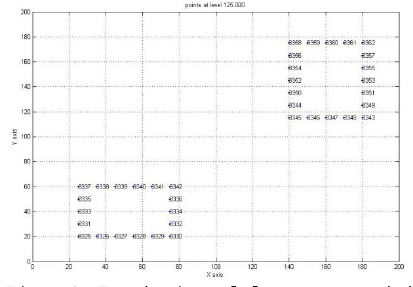
Figure 8. Two horizontal clusters are needed